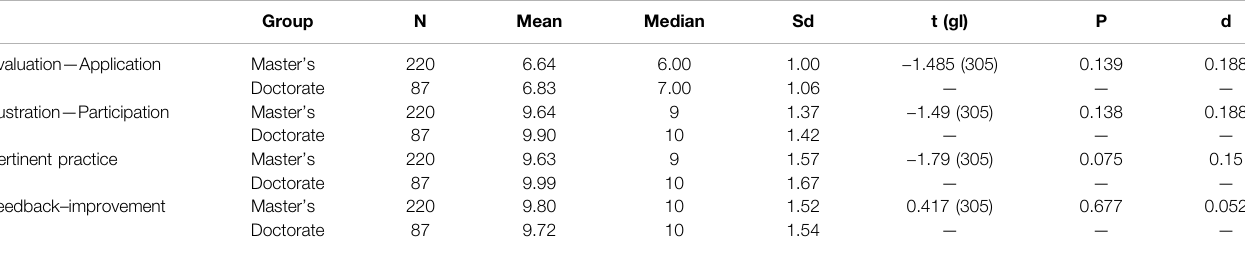
TABLE 7 | Comparison of self-assessment of student performance according to postgraduate